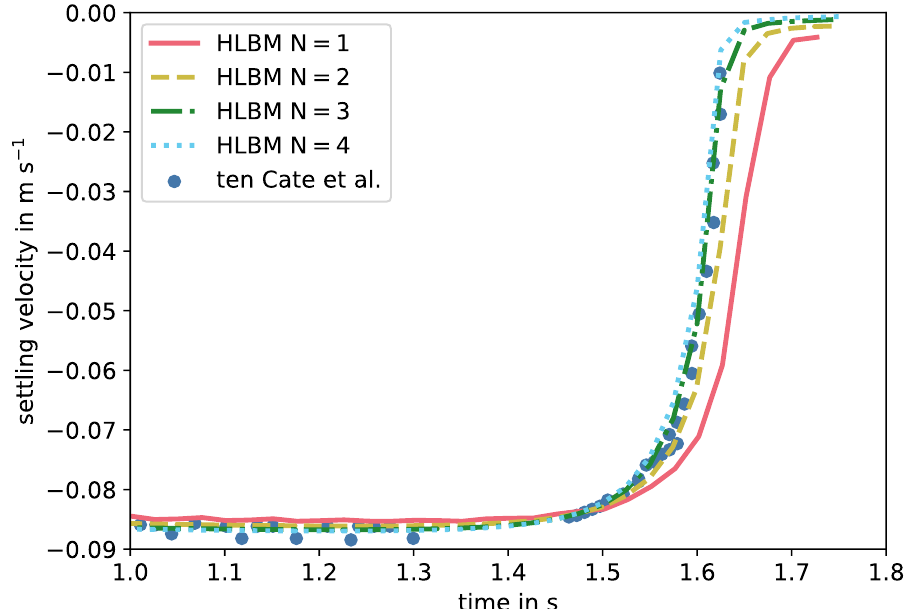
Figure 3. Extract of the results for the case of Re = 11.6 with exact difference method (EDM) and momentum exchange algorithm (MEA)-W for different grid spacings along with the experimental data by ten Cate et al. [49].